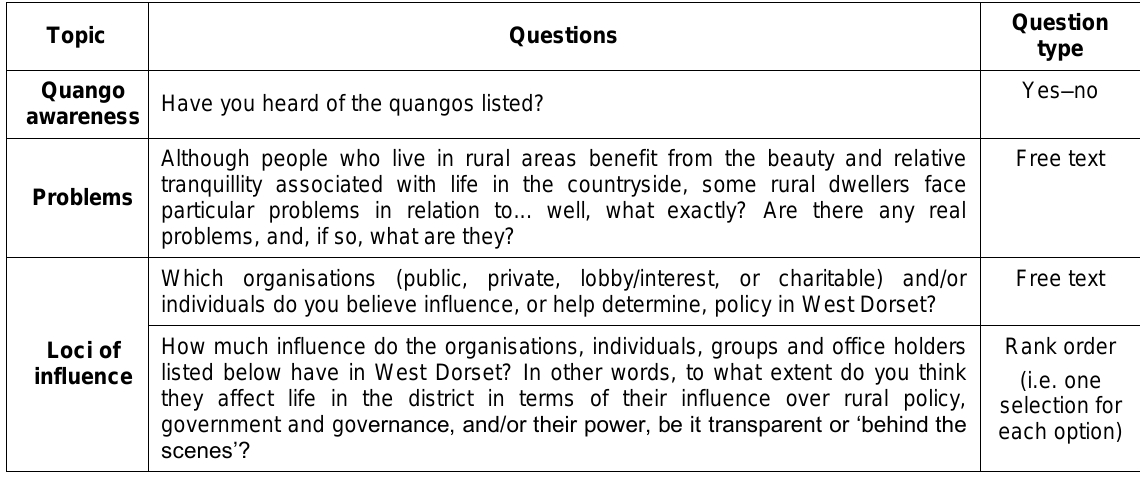
Table 1: Questions asked in online survey